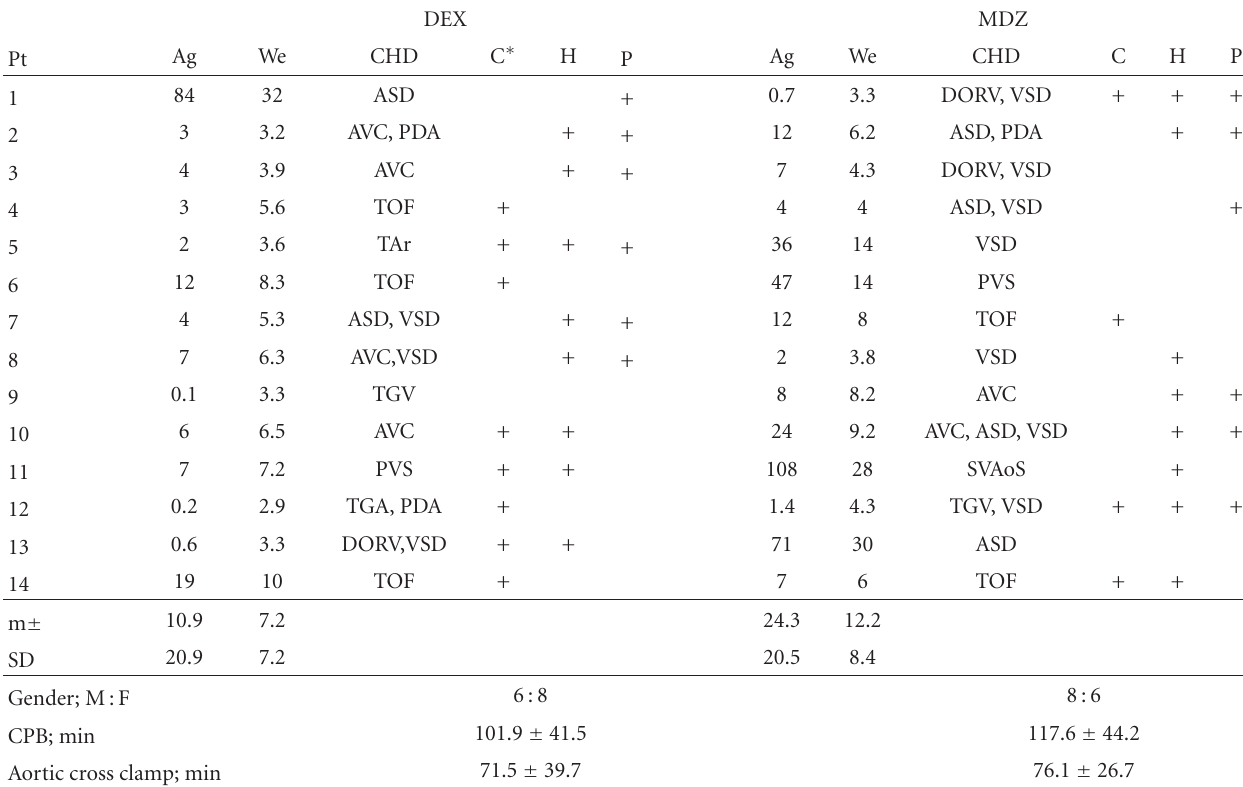
Table 1: Demographic, congenital heart disease (CHD), cardiopulmonary bypass (CPB), and aortic cross clamp time, and preoperative incidence of cyanosis (C), heart failure (H), and pulmonary hypertension (P) data. Values represent individual values and mean (m) ± SD. ∗ Statistical significance, P <